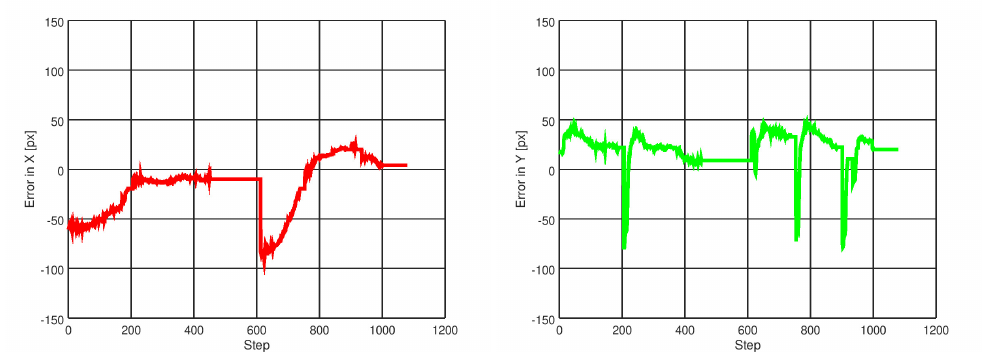
Figure 15. Example of 1 run for gate detection error in the X and Y image axes. This error approxi- mates to zero as the controller commands the drone to centre itself with respect to the gate. The plot on the left shows the reduction in error in the X axis twice, corresponding to the moments when the drone crosses two gates. To the right, note that the drone has some banging in pitch reflected in the error in the Y axis; this is due to a speed break occurring when the drone centres over the gate and decides to cross